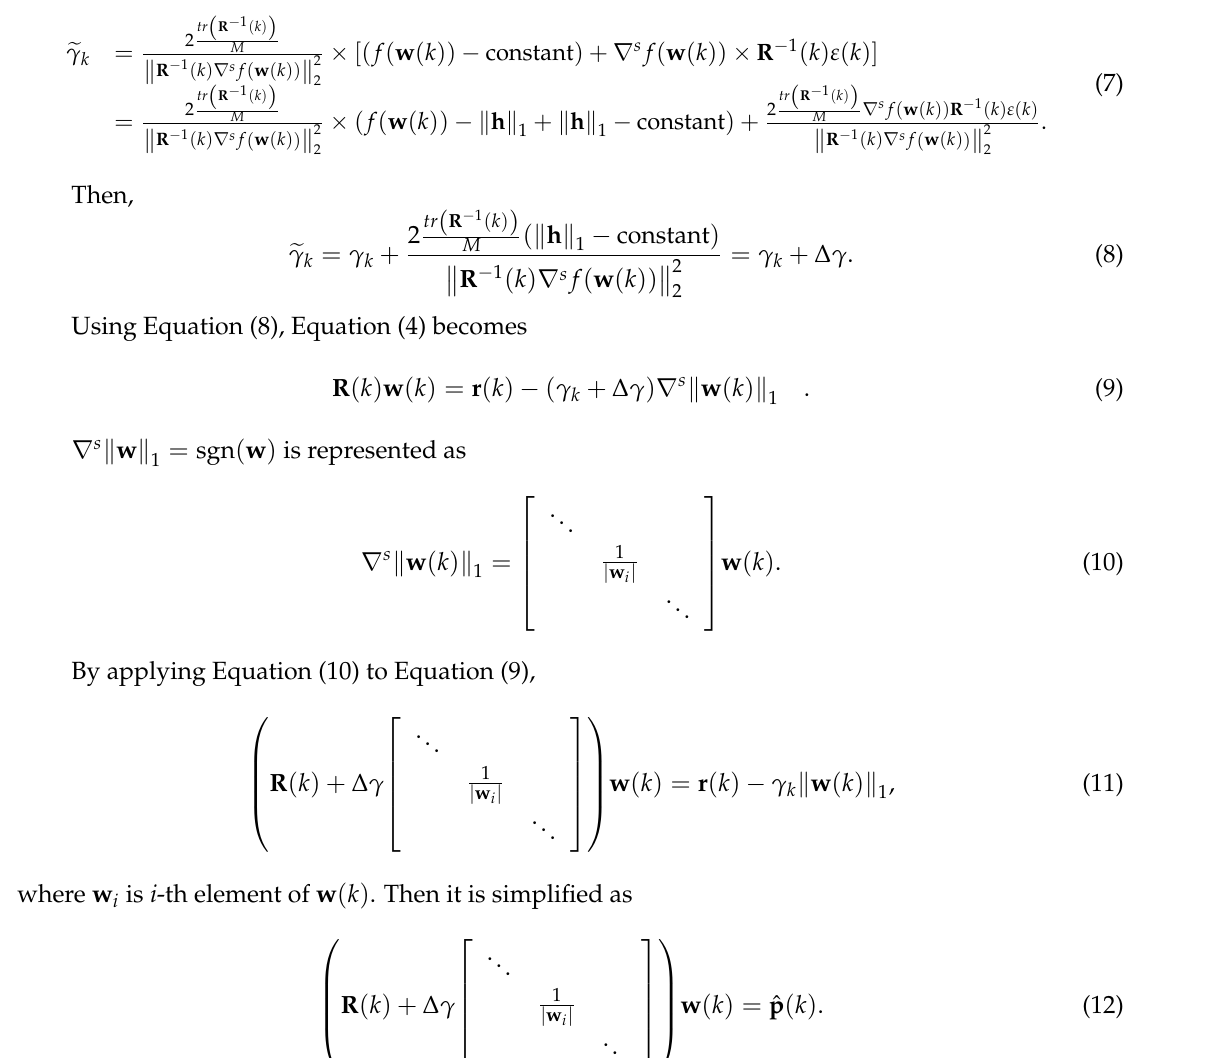
Sparsity: χ = L where L is the length of the impulse